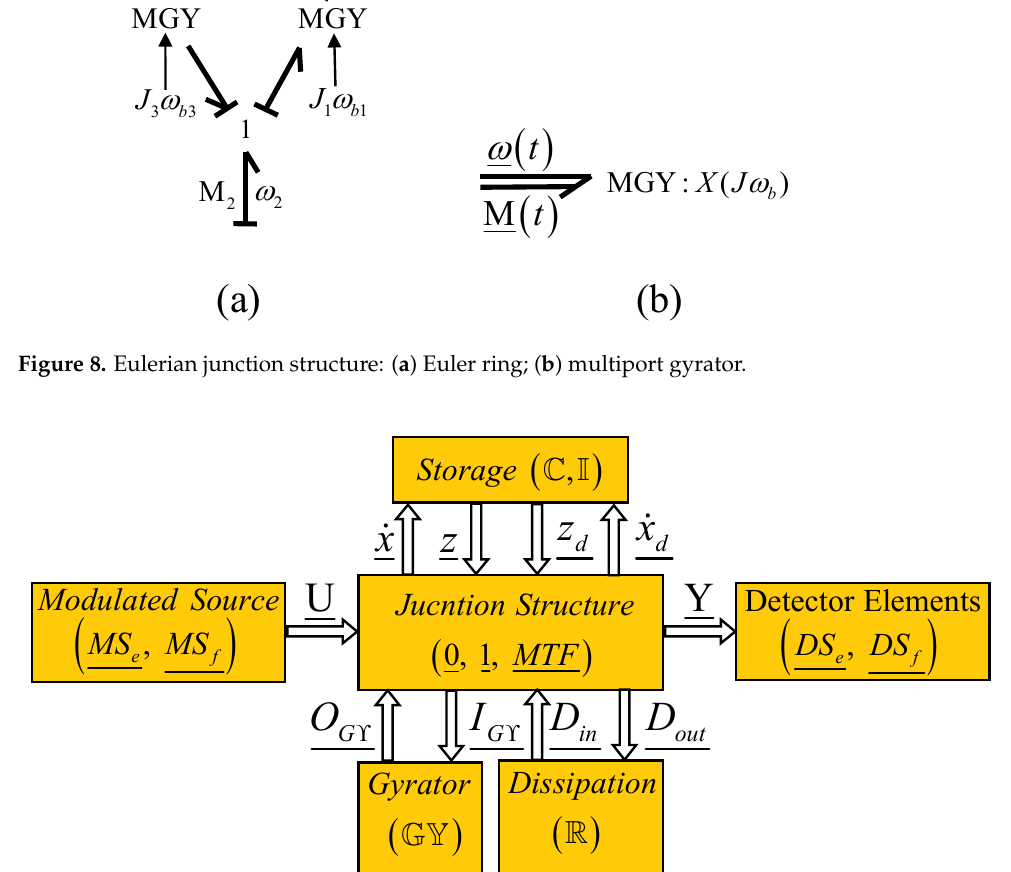
Figure 9. Junction structure and key vectors of a multibond graph with integral causality Fig. 7 . Junction structure